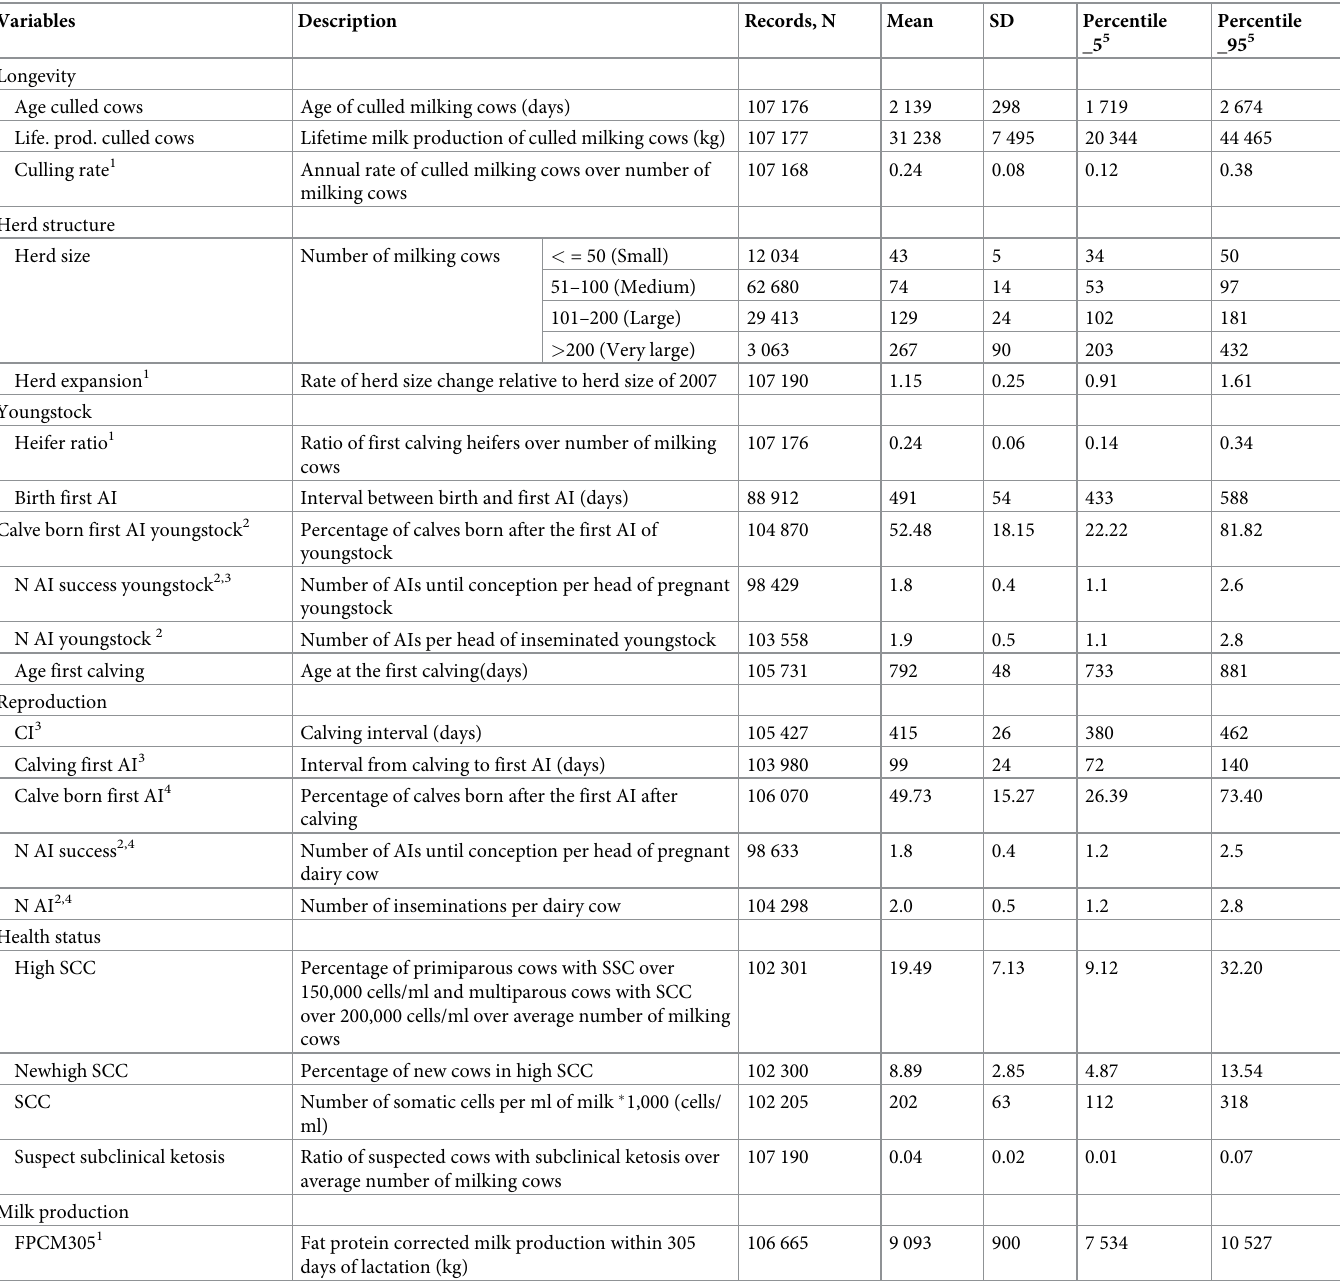
Table 1. Descriptive statistics on the selected herd performance indicators, indicating the distribution of herd averaged values across herds and years (2007–2016).